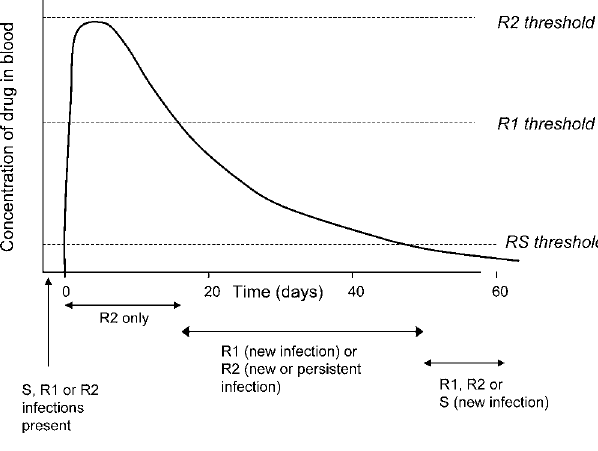
Figure 1. Pharmacokinetics of Drug Resistance Concentration of drug in the bloodstream declines over time and falls below threshold levels permissive for growth of parasites with varying degreesof resistance. DashedlinesrepresentpermissivethresholdsforRS, R1, and R2 parasites. Adapted from Hastings et al. [11]. RS, drug-sensitive parasites; R1, partially resistant parasites; R2, fully resistant parasites. DOI: